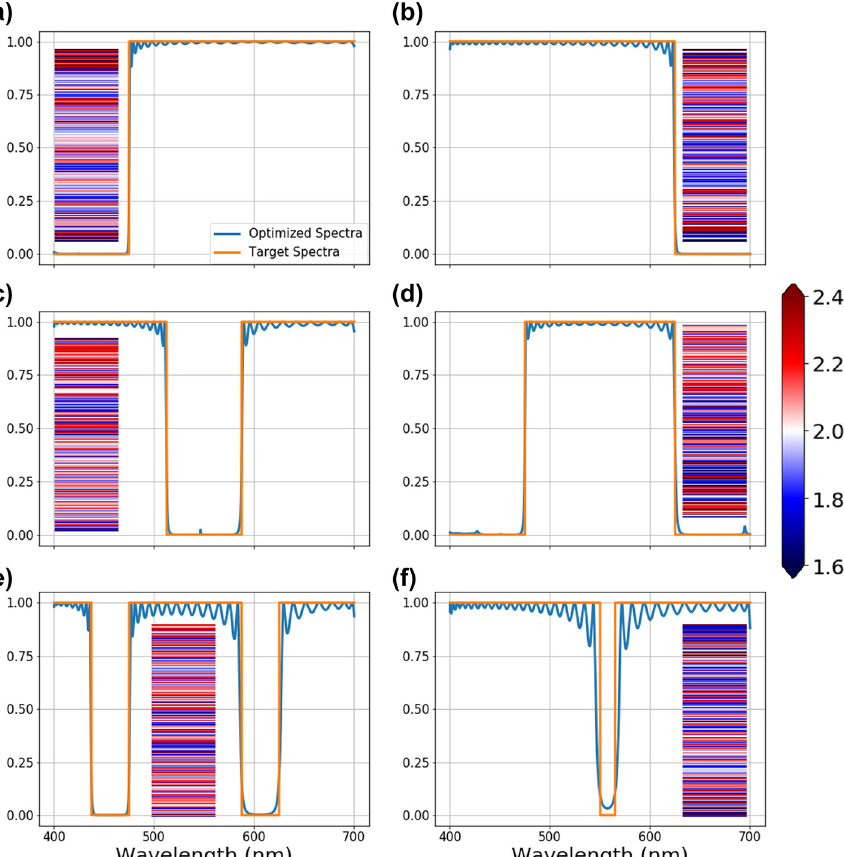
Figure 3: The results of the single material multilayer film optimization with continuously changing refractive index. The generated stacks are optimized for (a) high pass (475 nm cut-off), (b) low pass (625 cut-off), (c) band stop (525–575 nm), (d) band pass (475–625 nm), (e) double-band stop (437.5–475 nm and 587.5–625 nm), (f) and narrow band stop (550–565 nm) optical filters respectively. The insets show the refractive indices of the layers which range from 1.6 to 2.4. The color bar for the range of refractive indices in the stacks is shown on the middle right of the figure. The layer thicknesses and total number of the layers are 30 nm and 200,